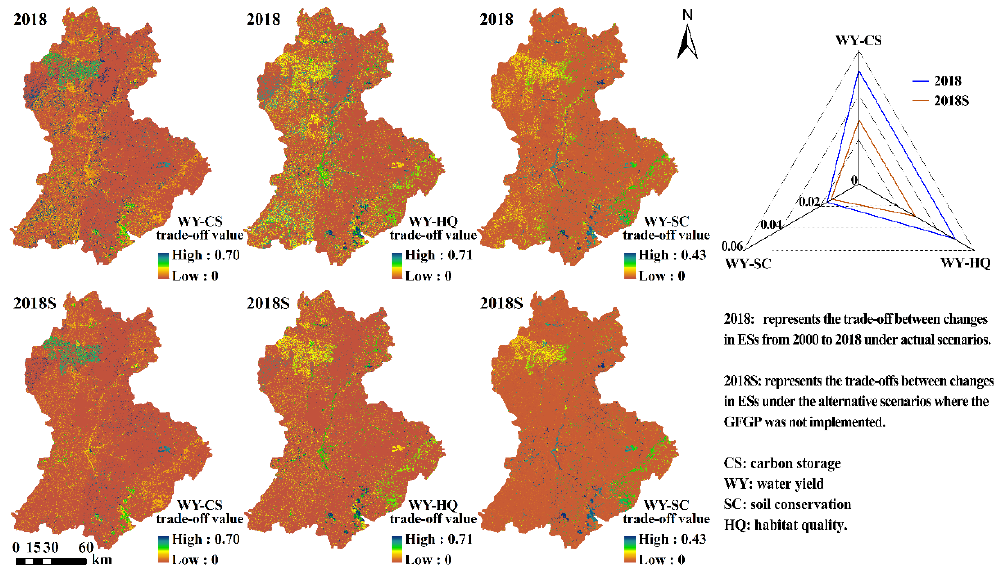
Figure 4. The spatial distributions of trade-offs between ESs. The radar graph on the right represents the average values of trade-offs between ESs.